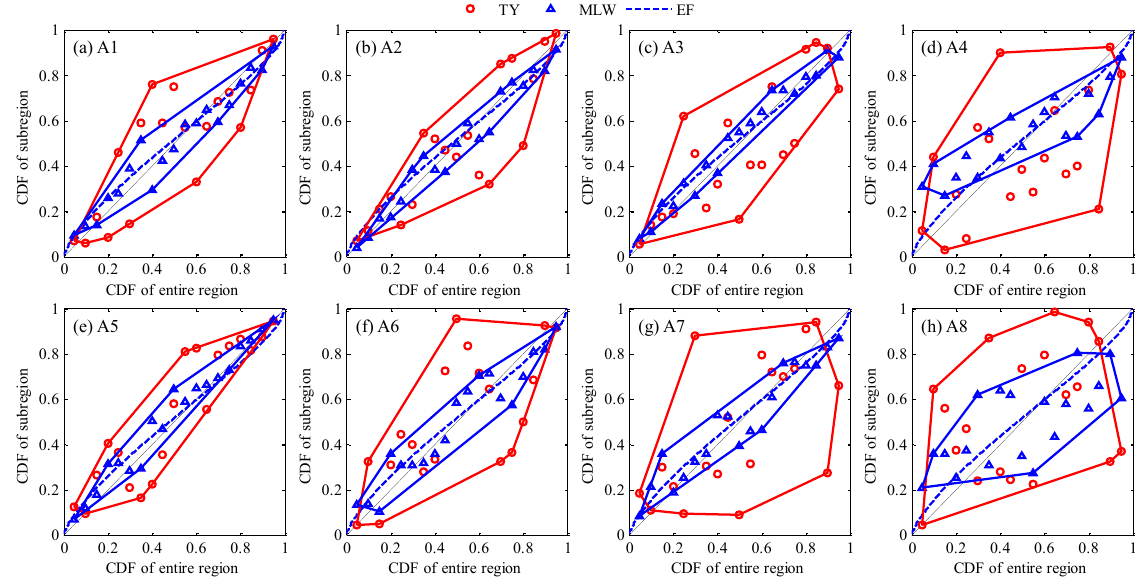
Figure 10. Design CDFs of sub-regions for given CDFs of precipitation of the entire region.